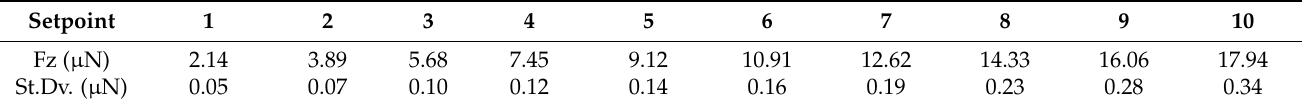
Table 1. Force values estimation by force